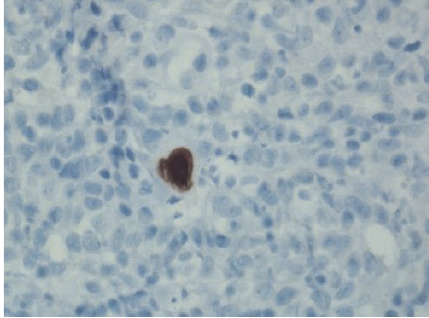
Figure 3: CMV immunostain.